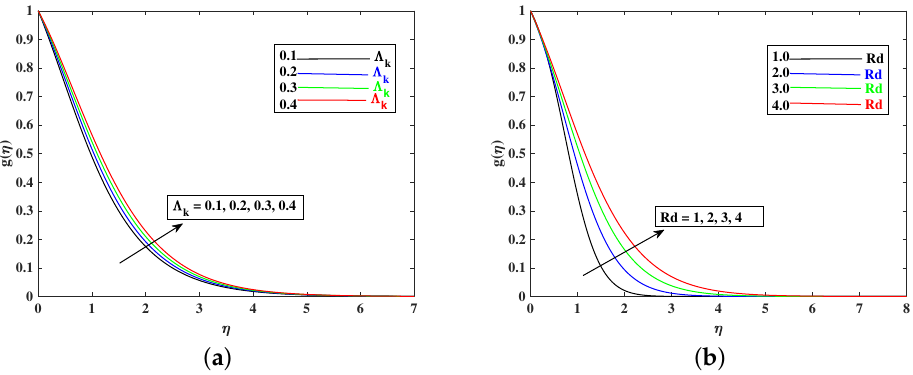
Figure 12. Variation of Λ k and Rd to influence the temperature profile. ( a ) Variation of Λ k to influence the temperature. ( b ) Variation of Rd to influence the